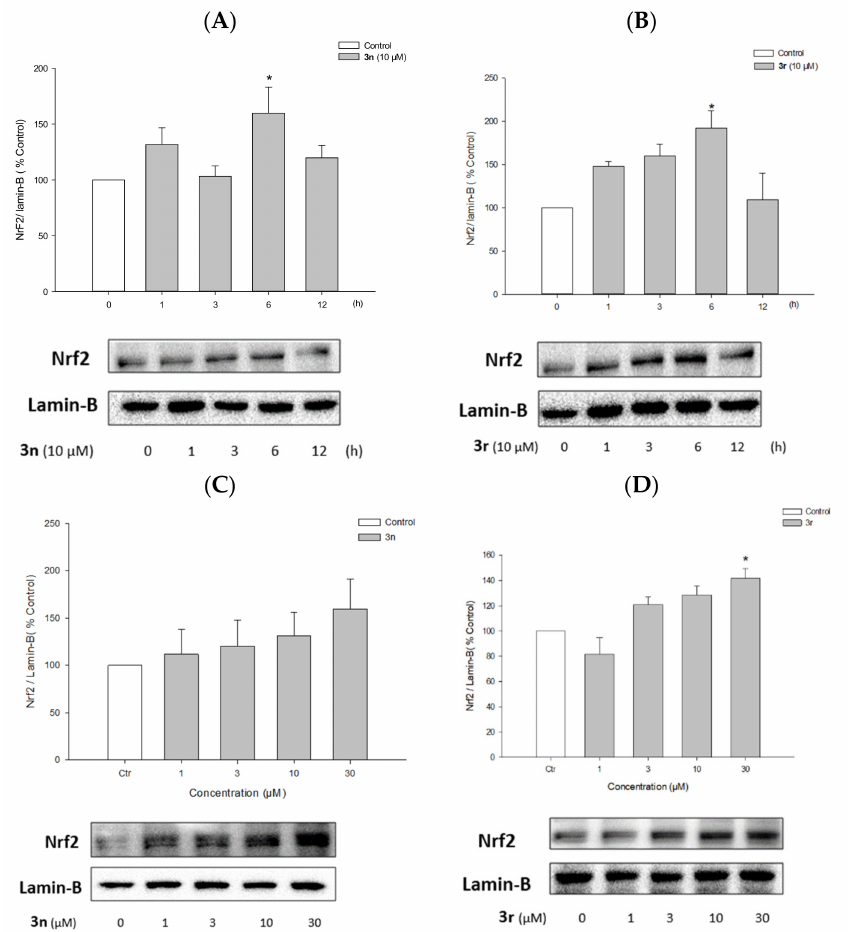
Figure 16. Effects of compounds 3n and 3r on the nuclear translocation of Nrf2. ( A , B ) PC12 cells were treated with compounds 3n ( A ) and 3r ( B ) at 10 µ M for the indicated periods of time. ( C , D ) PC12 cells were treated with compounds 3n ( C ) and 3r ( D ) for 6h at the indicated concentrations. Nrf2 protein expression in the nuclear fraction was analyzed by Western blotting as described in the Materials and Methods section. Lamin-B was used as the internal control. (Ctr, control, * p < 0.05 vs. the vehicle-treated control